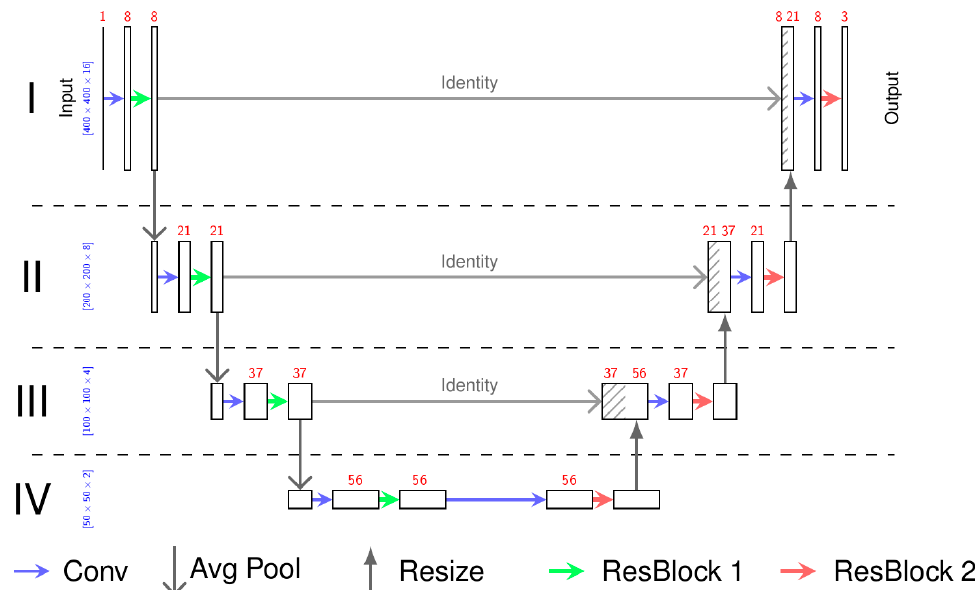
Figure 1. The architecture of the neural network: 3D U-Net. The input is a sample with the spatial dimension 400 × 400 × 16 of the MR image. The output has the same dimension containing the probability of the three classes (vertebral bodies, intervertebral discs, and spinal canal). The red numbers represent the number of feature maps, whereas the blue numbers define the spatial dimension of the feature maps. All arrows define functions between these feature maps as described in the picture. The Residual Blocks (ResBlock 1, ResBlock 2) are shown in Figure 2.